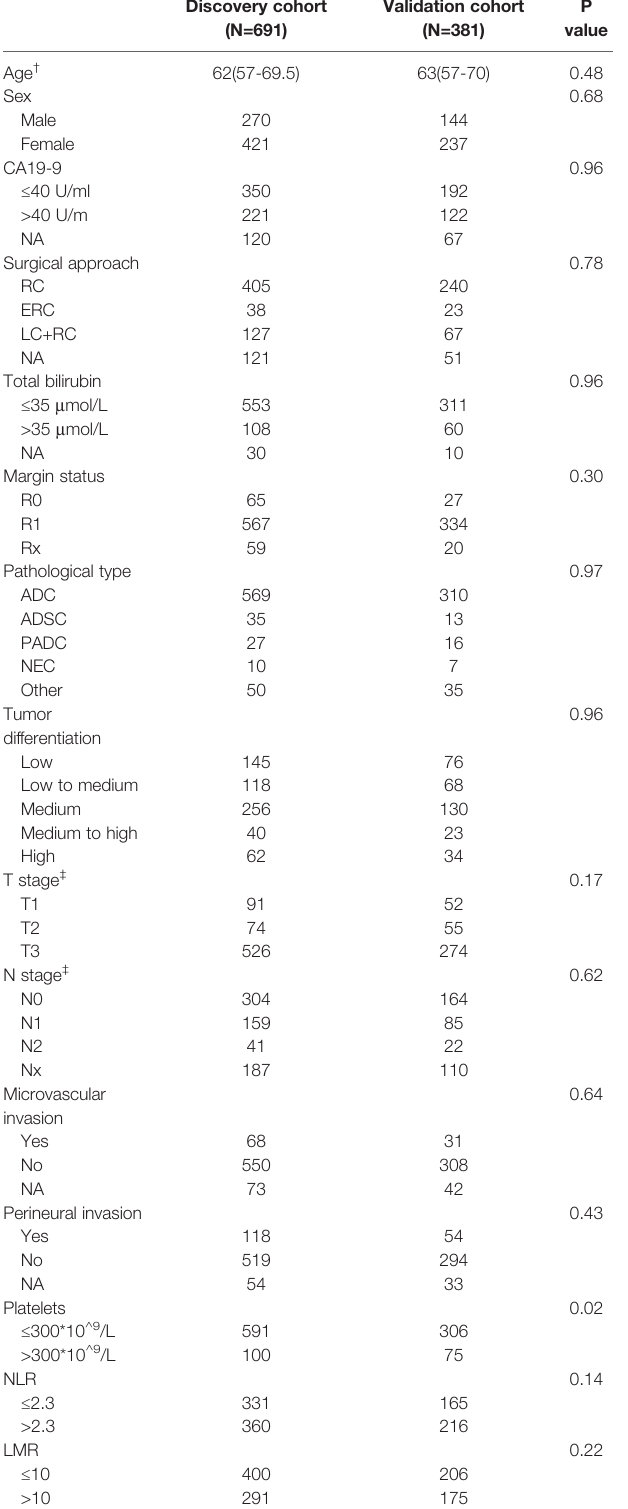
TABLE 1 | Clinicopathological Characteristics of the GBC Patients in the Discovery and Validation Cohorts. Discovery cohort